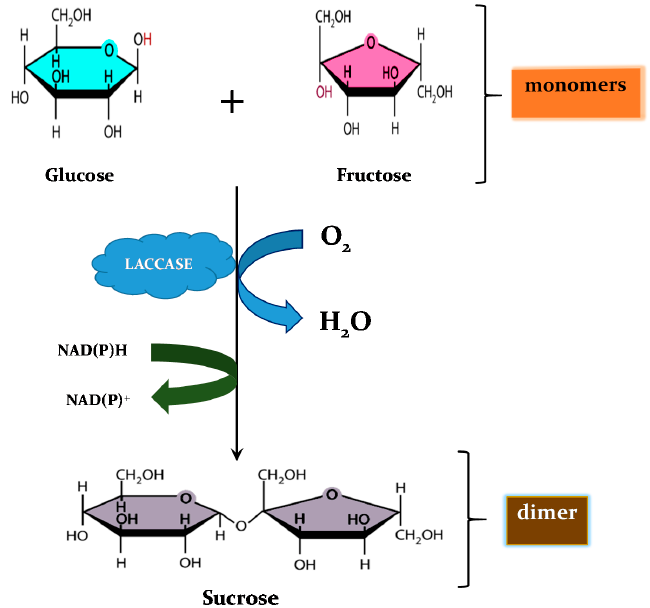
Figure 1. The hypothetical cross-linking of the fruit monomeric sugars, glucose and fructose to form the dimer sucrose or invert sugar.